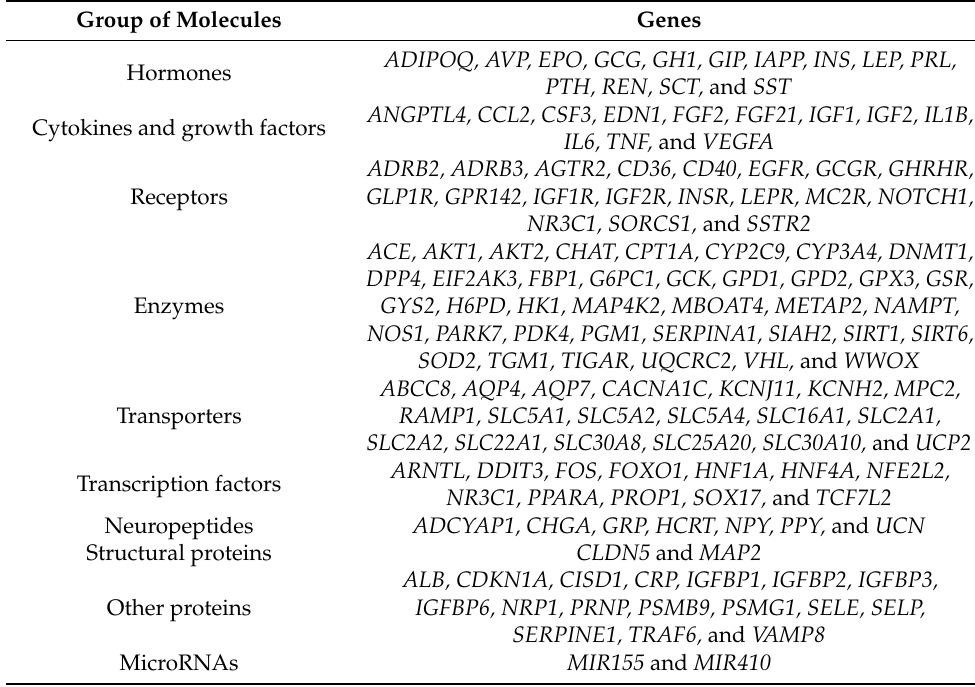
Table 1. Molecules of the hypoglycemia